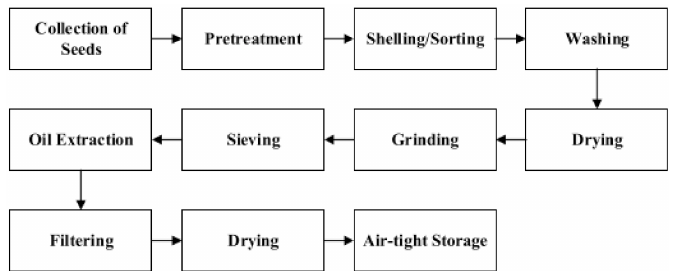
Figure 2. Flow chart of natural coagulant preparation from seeds, copied with permission from Ref. [10], Copyright, 2021,